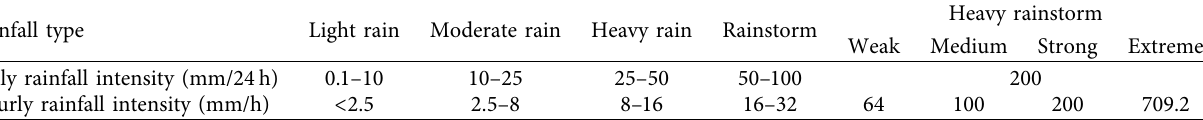
Table 2: Rainfall intensity scale.